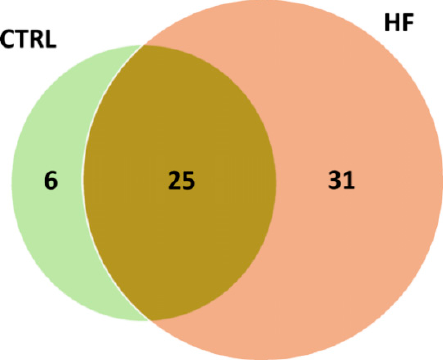
Table 1. List of AGE/ALE adducts identified on HSA in control and HF samples and the corresponding aminoacidic sites. Protein Adducts